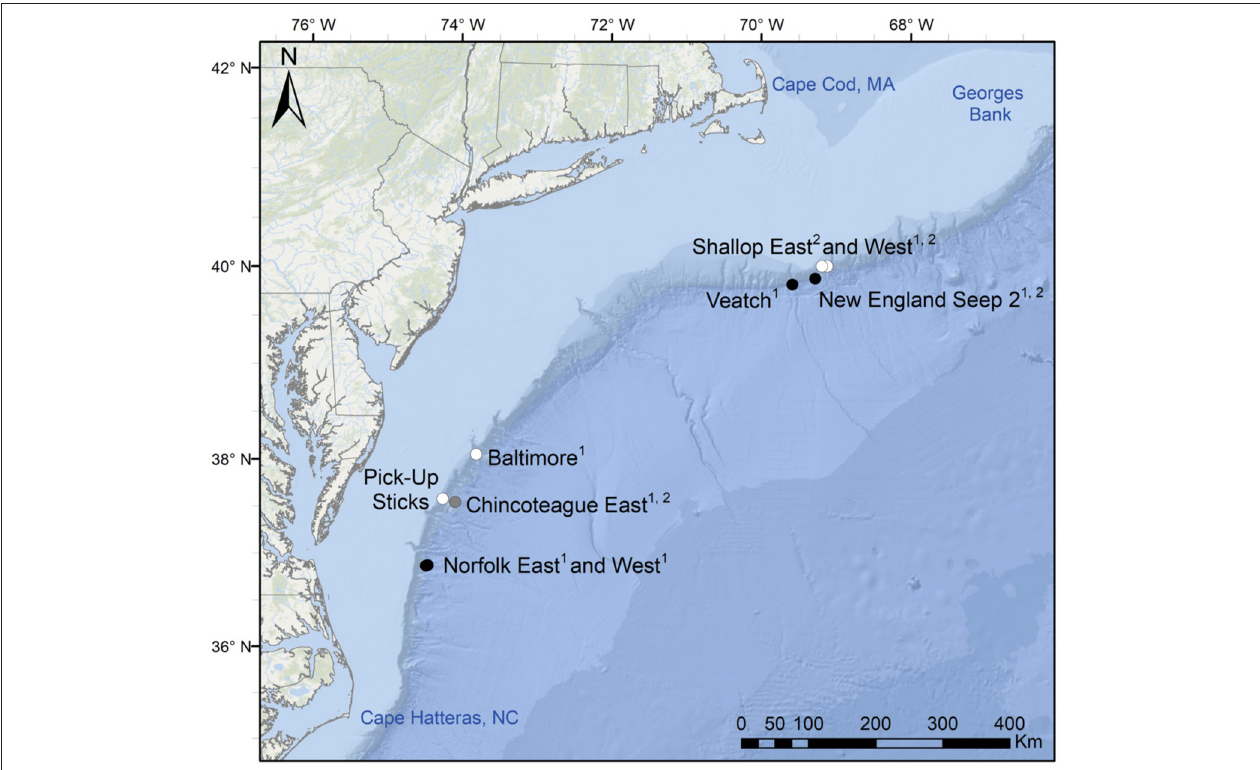
FIGURE 1 | US Atlantic margin seep study sites. White symbols: shallow sites ( ∼ 400m), gray symbol: intermediate depth ( ∼ 1,000m), black symbols: deep sites ( ∼ 1,500m). Locations of samples for stable isotope analyses: 1 bathymodiolin mussels, 2 red crabs. Service layer credits: Esri, Garmin, GEBCO, NOAA NGDC, and other contributors.